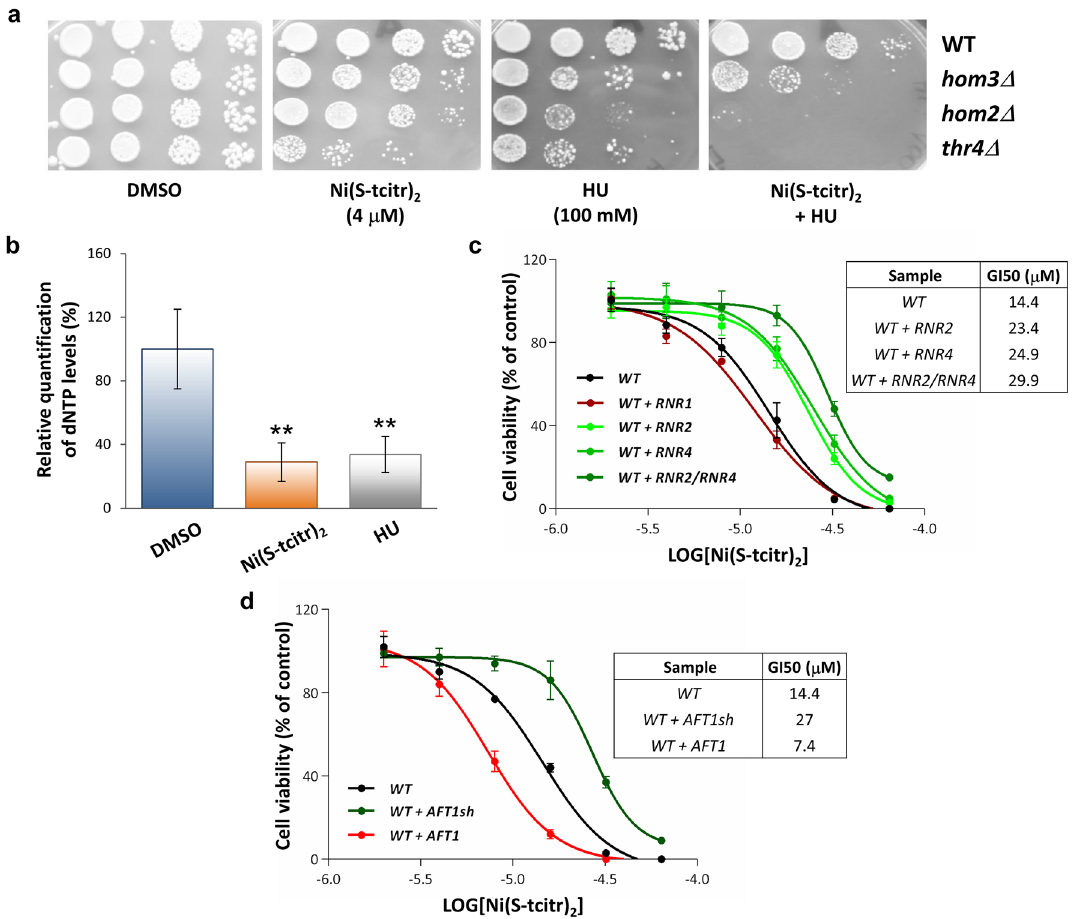
Figure 4. Effects of Ni(S-tcitr) 2 on dNTP synthesis and iron trafficking pathways. ( a ) Synergistic toxicity of Ni(S-tcitr) 2 and HU. Serial dilutions of WT yeast cells and of the indicated threonine biosynthesis deletion mutant strains were plated on YPD plates containing sublethal concentration of Ni(S-tcitr) 2 (4 µM) and/or of the RNR inhibitor hydroxyurea (HU; 100 mM) as indicated. ( b ) Relative quantification data derived from dNTP levels measurements performed on Ni(S-tcitr) 2 -and HU-treated WT yeast cells as indicated. Data were analyzed by one-way ANOVA followed by Dunnett comparison post-hoc test (** P -value < 0.01). ( c ) Survival curves of yeast strains overexpressing specific RNR subunits. WT cells transformed with genes coding for the R1 ( RNR1 ) or the R2 ( RNR2 and RNR4 ) subunits were grown in the presence of increasing concentrations of Ni(S-tcitr) 2 ; cells transformed with the empty expression vectors (YEplac195 and YEplac112) served as controls. For each overexpressing strain, the results are expressed as percentage of cell viability relative to the control cells (treated with DMSO; arbitrarily set to 100%). The half maximal growth inhibition (GI50) values derived from these experiments are calculated using GraphPad Prism 6 software and shown in the inset. ( d ) Survival curves of yeast strains overexpressing the full-length ( AFT1 ) and the truncated form ( AFT1sh ) of the iron regulon master regulator Aft1. WT cells transformed with genes coding for Aft1 or Aft1sh were grown in the presence of the indicated concentrations of Ni(S-tcitr) 2 ; cells transformed with the empty expression vector YEplac195 served as controls. Data were analyzed as described above in the legend to panel